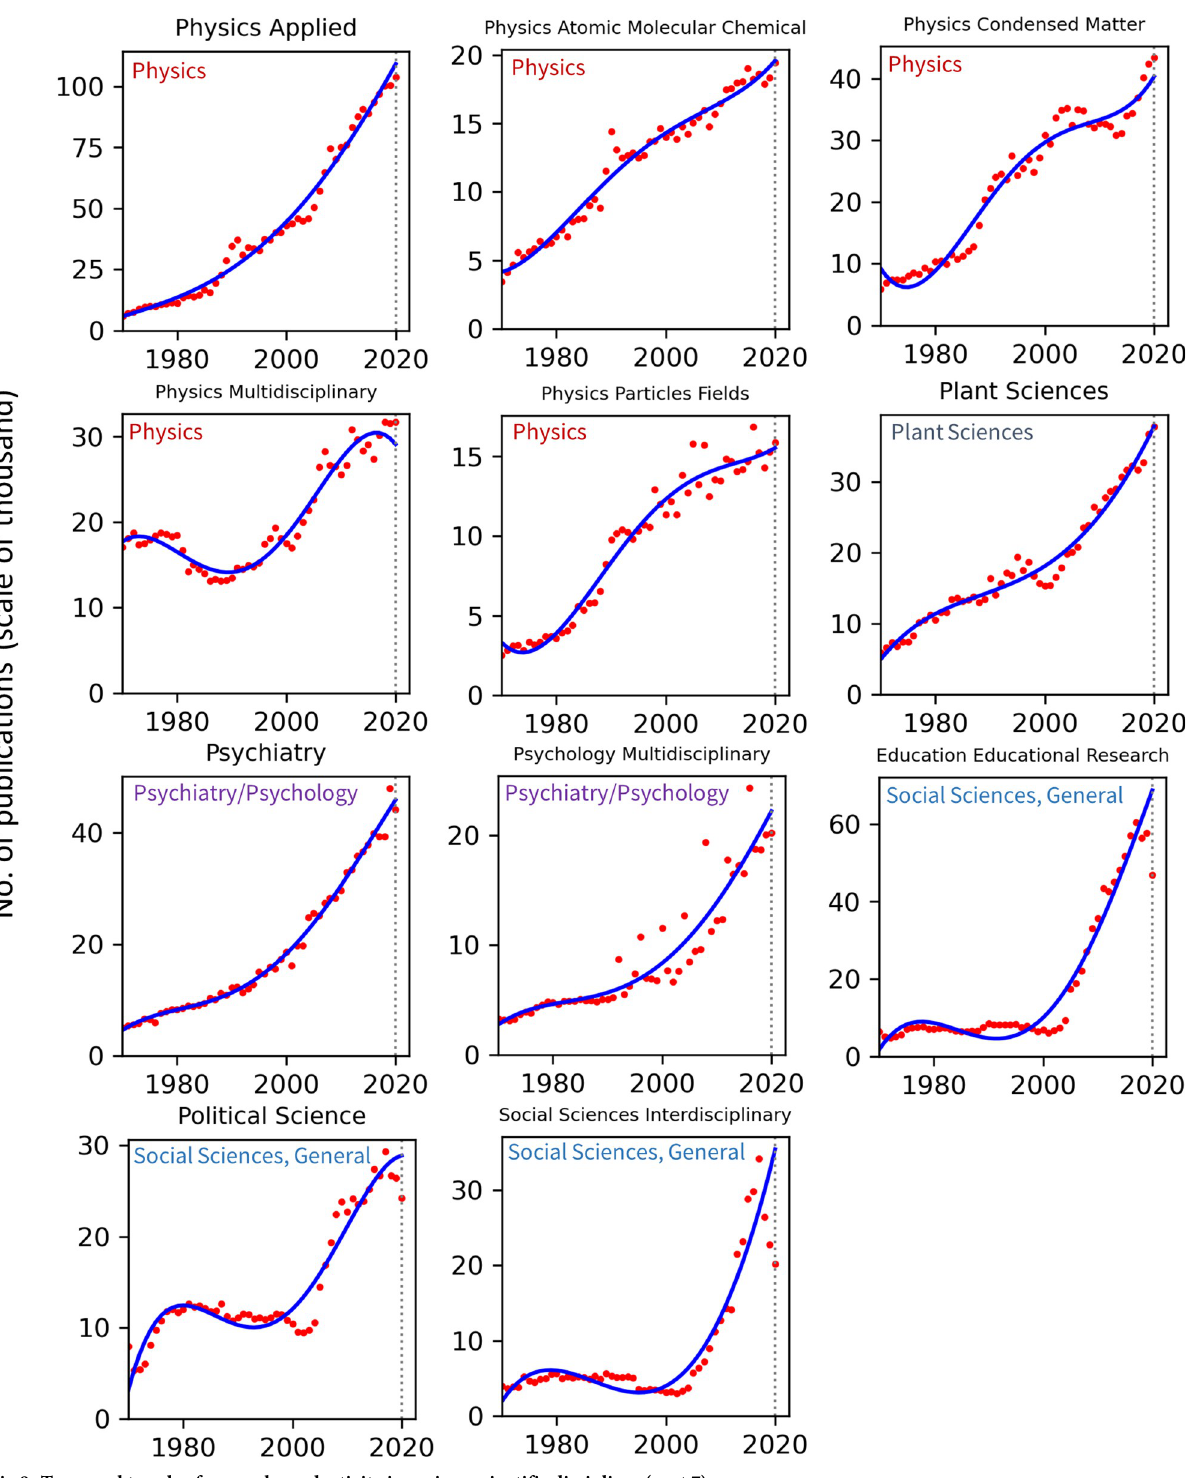
Fig 8. Temporal trends of research productivity in various scientific disciplines (part 7).